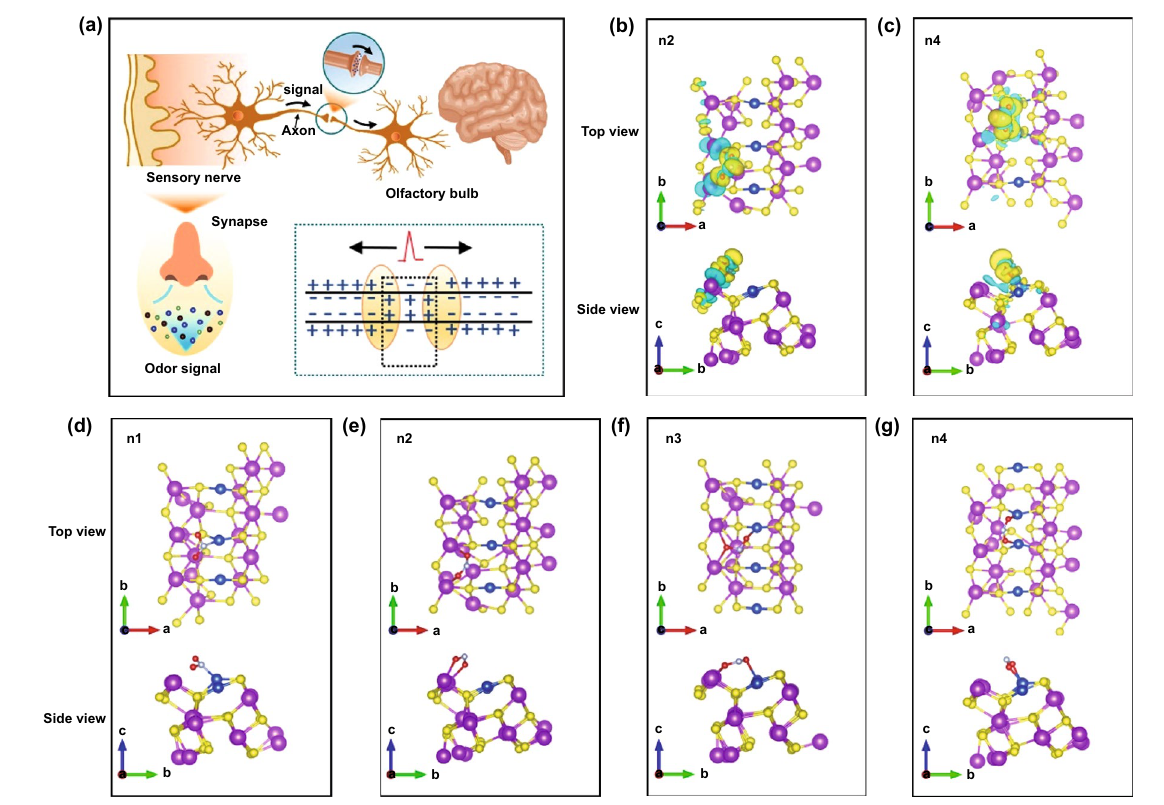
Fig. 1 a Schematic diagram of charge change of biological olfactory system during stimulation. Sensing mechanism and the possible interaction energy of gases with configurations on the CuS QDs/Bi 2 S 3 NSs using DFT calculations. b and c Diagrams of charge density difference of NO 2 on CuS-Bi 2 S 3 with n2 and n4 binding structure for side and top view, where the charge density isosurfaces of blue and yellow are 0.0015 and -0.0015 e Å −3 , respectively. d‑g Binding structures of NO 2 on CuS-Bi 2 S